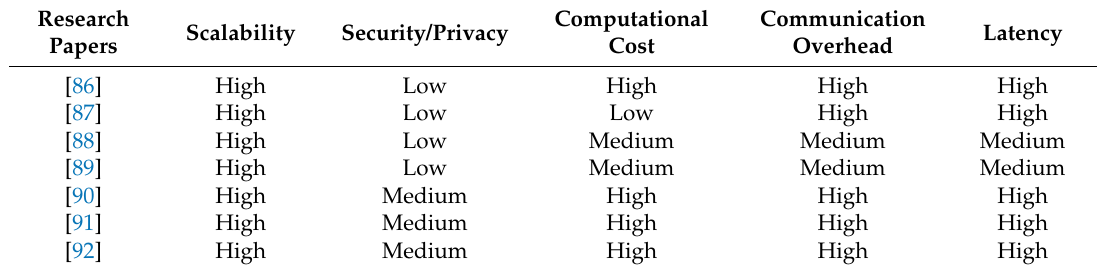
Table 4. Asymmetric based encryption schemes performance.